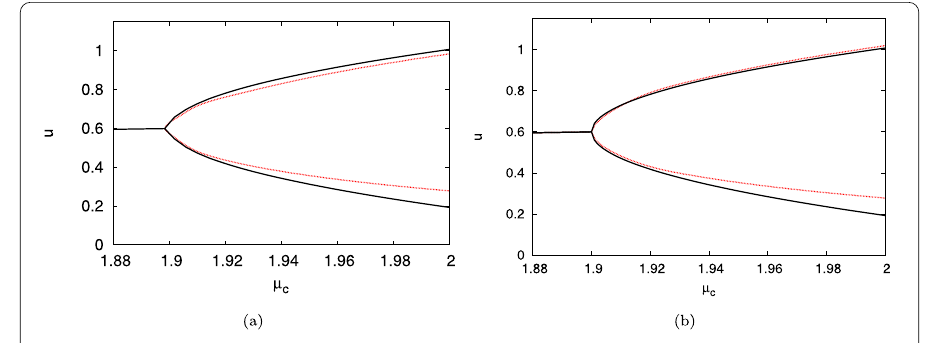
Figure 11 (color online) Bifurcation diagram of the population density in the μ – u map. The semi-analytical solutions (red dotted curve) and perturbation solutions (black solid curve) are obtained